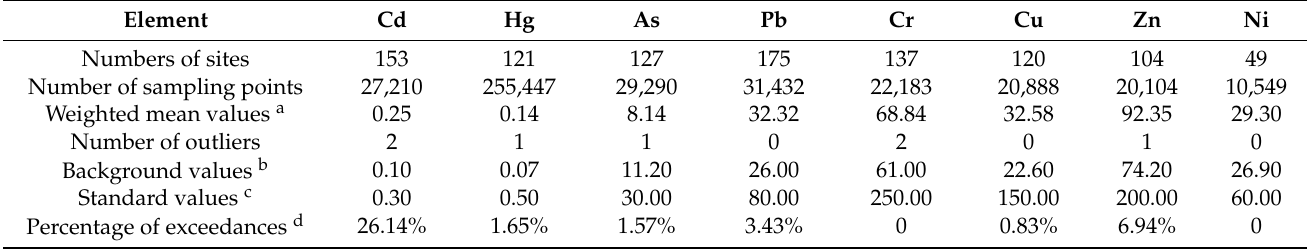
Table 1. Regional mean values (mg kg − 1 ) of eight elements in agricultural soil in the Yangtze River Delta (YRD). Element Cd